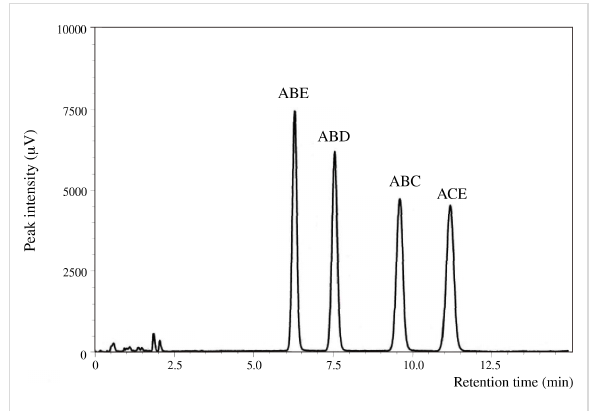
Figure 2: UFLC chromatogram of four regioisomers of tri-6- O -trityl- α - CD with an eluent of acetonitrile/methanol/water (40:45:15, v/v/v).